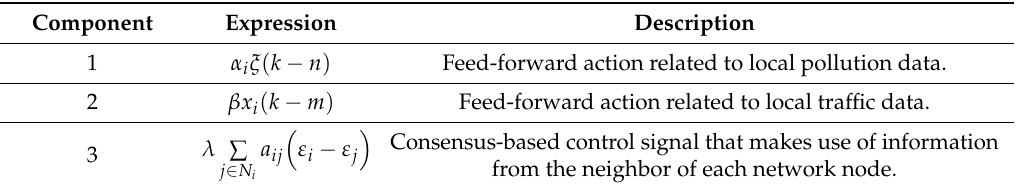
Table 2. Components of the control